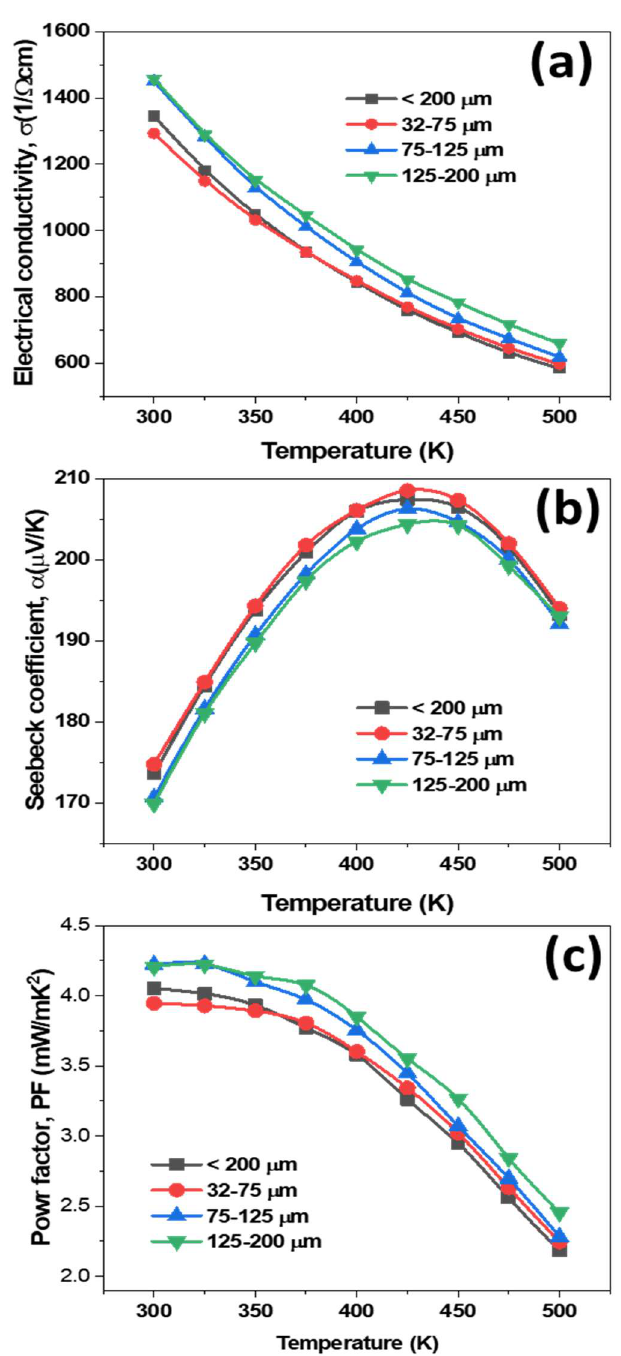
Figure 5. Temperature dependence of ( a ) electrical conductivity, ( b ) Seebeck coefficient, and ( c ) power factor for different water atomized powder sizes of p-type Cu 0.07 Bi 0.5 Sb 1.5 Te 3 bulk specimens.